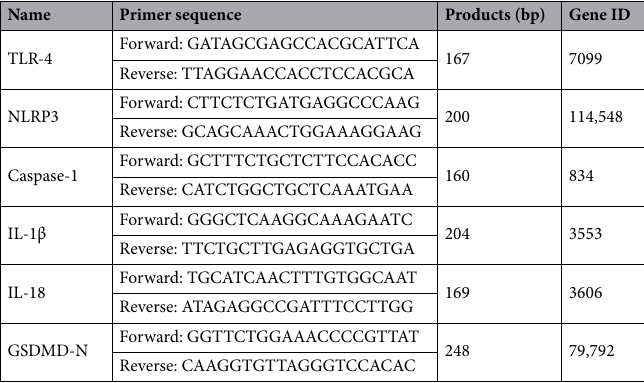
Table 2. Oligonuceotide sequences for Homo sapiens gene